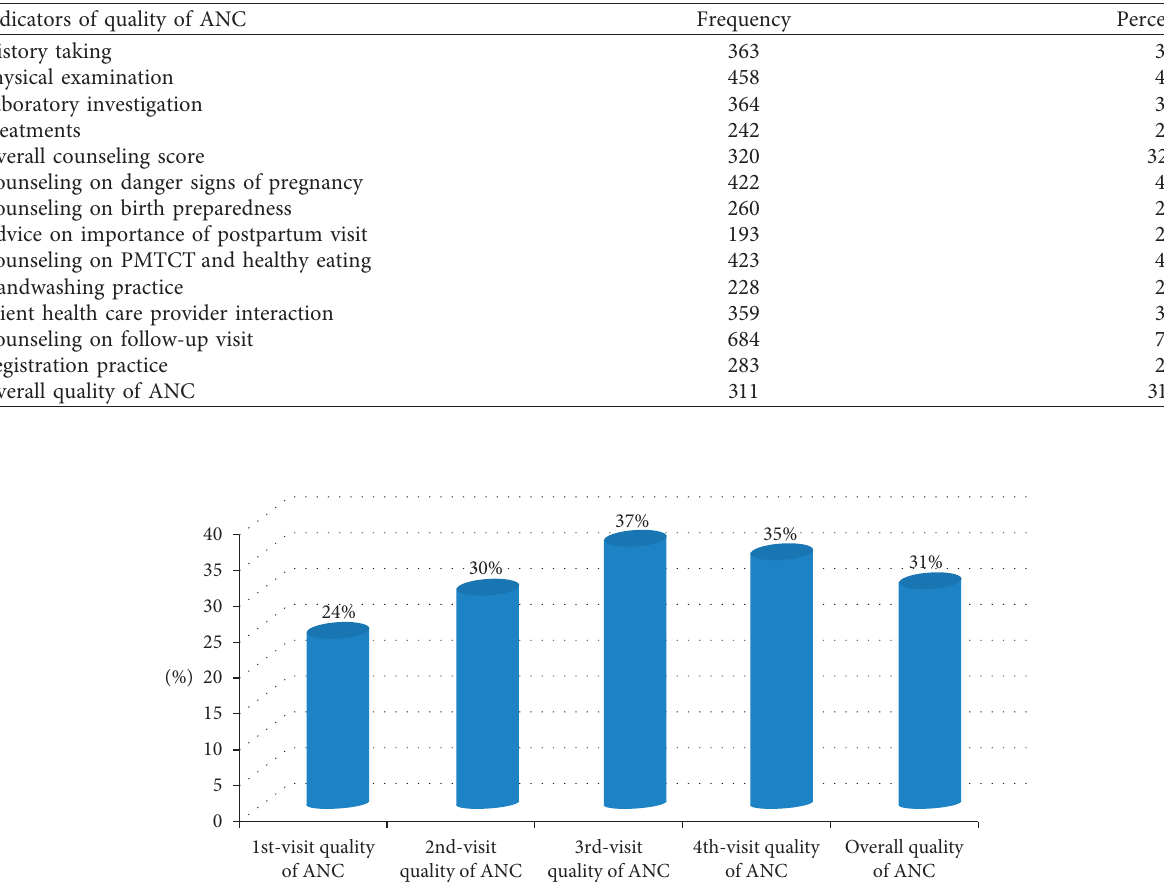
Figure 1: Quality of services during visit of study participants ( n � 980) observed at Hossana Town’s public health facilities, Southern Ethiopia, July 2017 to June